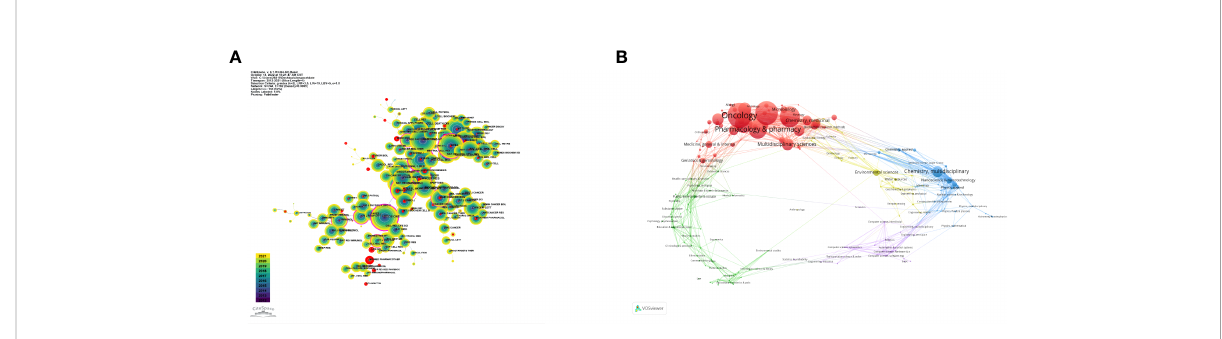
FIGURE 6 Visualization of co-cited journals on lung disease-related autophagy. (A) Circles denote co-cited journals; connecting lines stand for journal interaction. (B) Superposition analysis of research fi